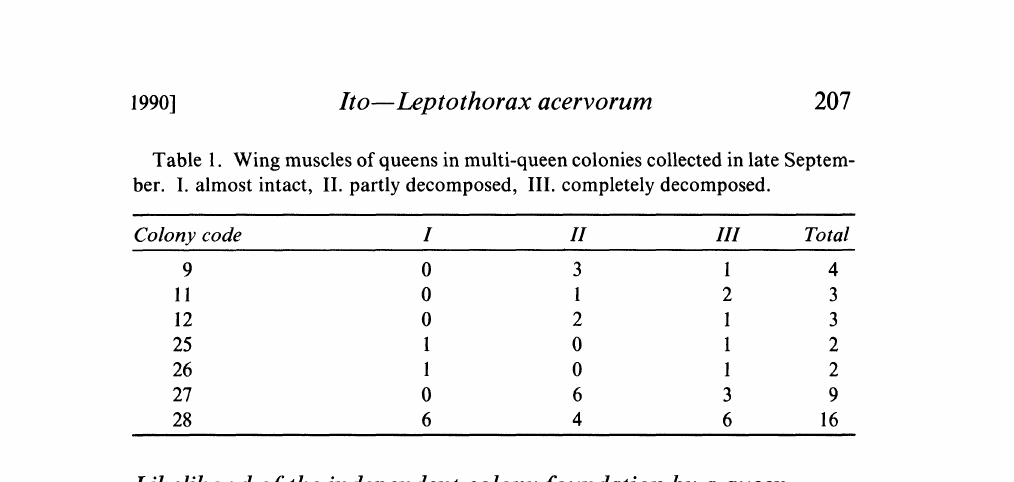
Table 1. Wing muscles of queens in multi-queen colonies collected in late Septem- ber. I. almost intact, II. partly decomposed, III. completely decomposed.